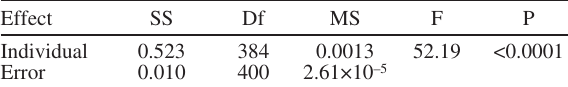
Table 1. – Summary of Procrustes ANOVA for estimating the measurement error in the digitalization of landmarks on larval and juvenile Sicyases sanguineus .